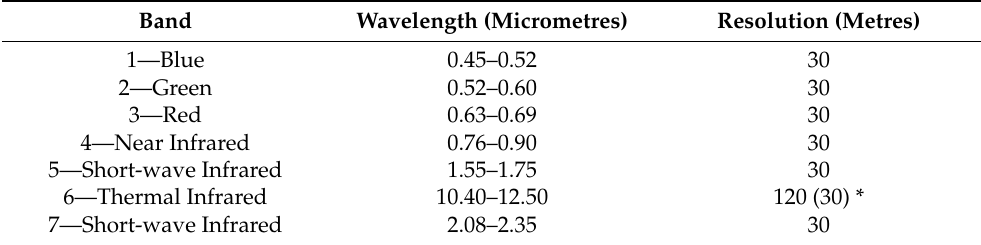
Table A1. Landsat 4 and Landsat 5 Thematic Mapper (TM) 1998 imagery (Data Taken from USGS [64,65]).